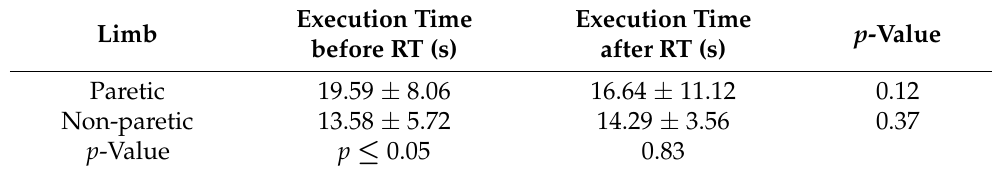
Table 13. Execution time of the Apley Scratching Test before and after the rehabilitation